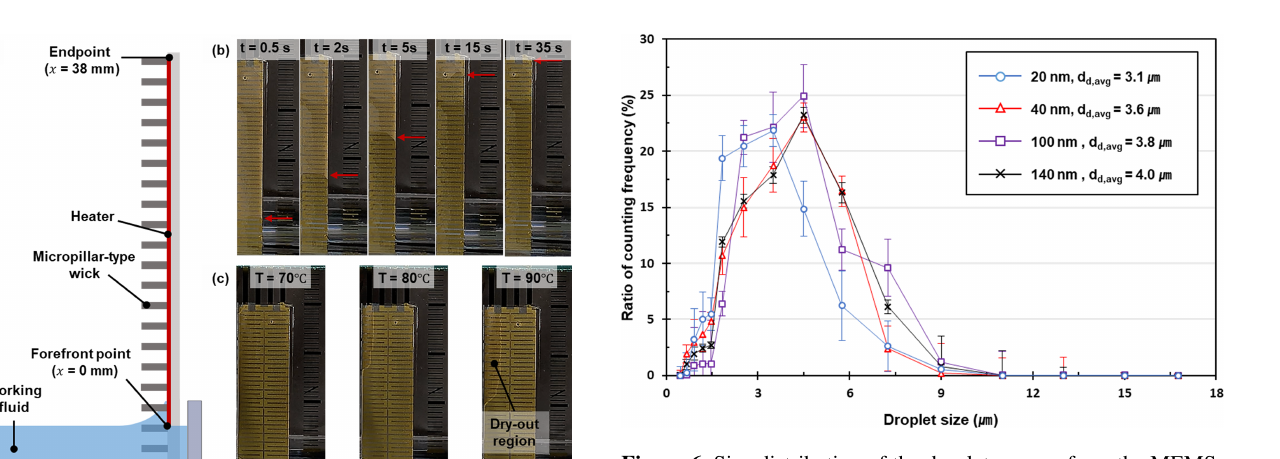
Figure 6. Size distribution of the droplets grown from the MEMS- based particle growth system when Ag particles of specific sizes were